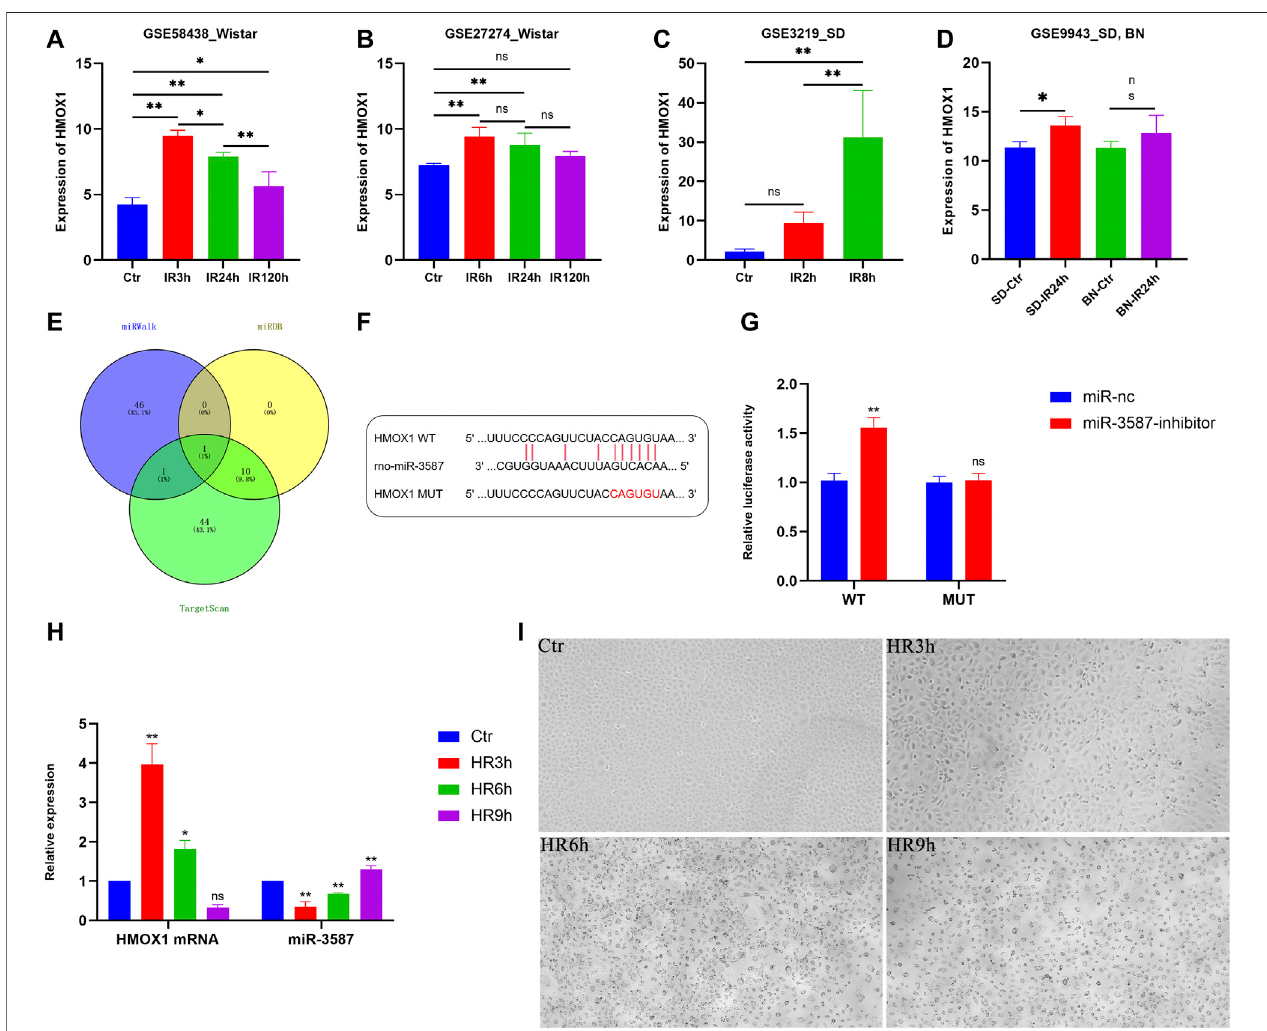
FIGURE3| Analysisof HMOX1 expressionpatternsindifferentdatasetsand invitro veri fi cationoftherelationshipbetween HMOX1 andmiR-3587. (A – D) Trendsin HMOX1 expression in the different datasets. (E) Venn diagrams showing miRNAs targeting HMOX1 . (F) Predicted sequence complementarity between miR-3587 and HMOX1 . (G) The luciferase assayshowed thatthemiR-3587inhibitor, but not themutant, increased wild-type HMOX1 mRNA expression. (H) PCR-mediated detection of HMOX1 and miR-3587 expression at different time points following hypoxia-reoxygenation. (I) Light microscopy analyses of cell morphology in the Ctr, HR3h, HR6h, and HR9h groups. Scale bar (cid:2) 4 µm. Magni fi cation × 200. ns, p > 0.05; *, p < 0.05; **, p < 0.01.; Abbreviations: HMOX1, heme oxygenase 1; miR-3587, microRNA-3587; Ctr, control; HR, hypoxia-reoxygenation; SD, Sprague Dawley; BN, Brown Norway.